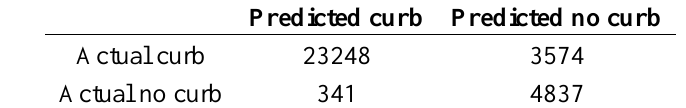
Table 2. The confusion